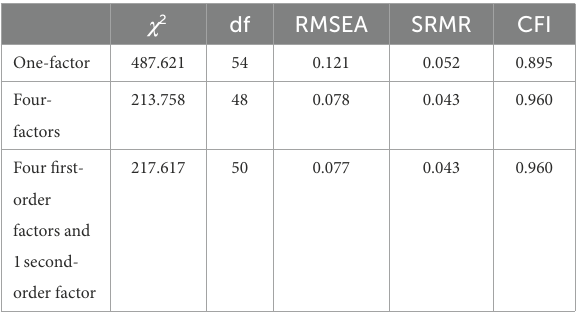
TABLE 1 Fit indices for the confirmatory factor